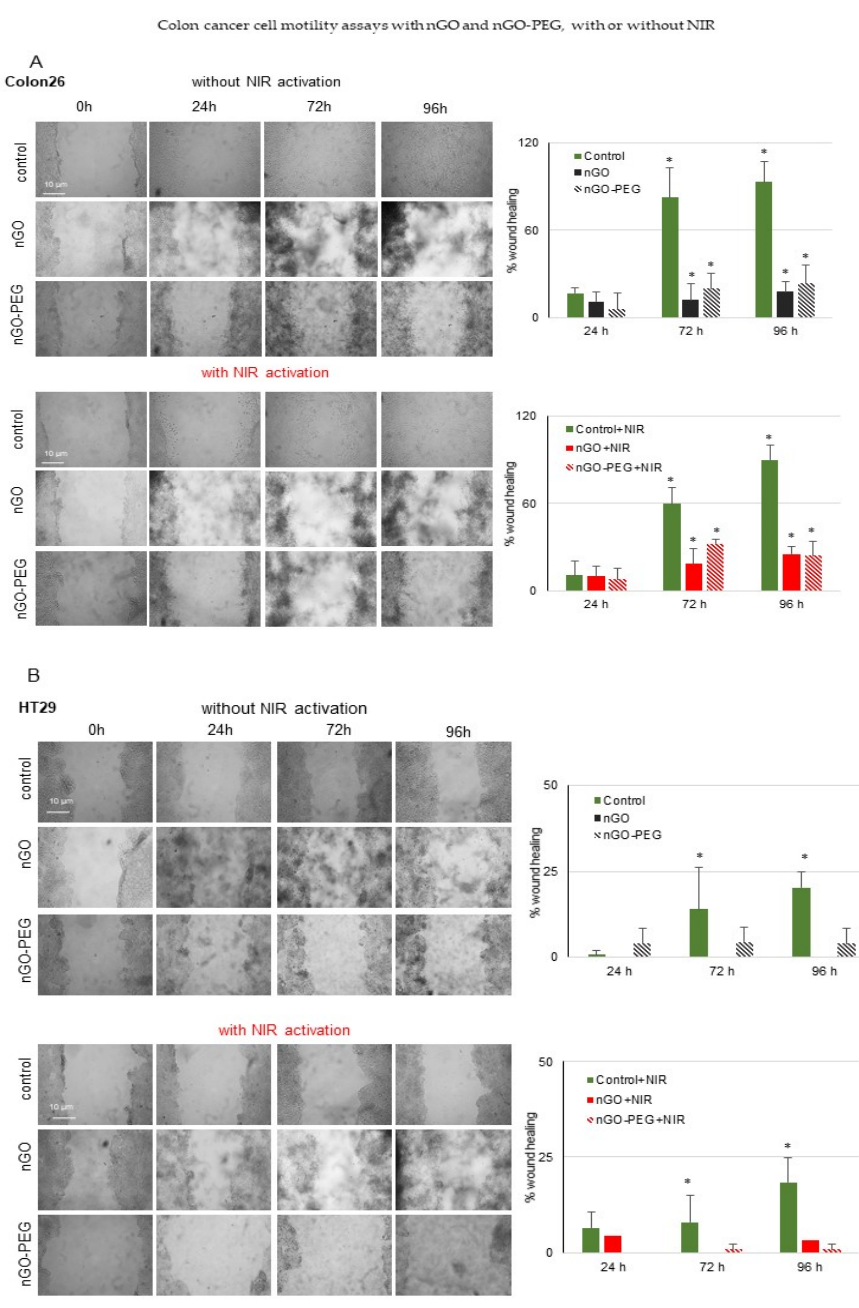
Figure 7. Inhibition of colon cancer cell migration in the presence of nGO and nGO-PEG, with and without NIR activation. ( A ) Wound healing assay of Colon26 cells treated with nGO and nGO-PEG with and without NIR activation. ( B ) Wound healing assay of HT29 cells treated with nGO and nGO-PEG with and without NIR activation. The statistical differences between the control and the treated groups were evaluated by one-way analysis of variance (ANOVA) followed by Dunnett’s post-hoc test and the data are considered significant when p < 0.05, designated with *.